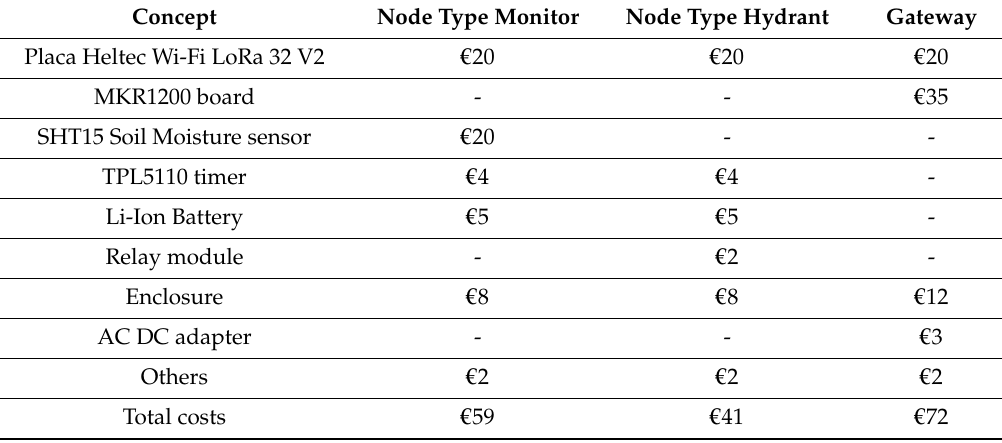
Table 8. Total equipment